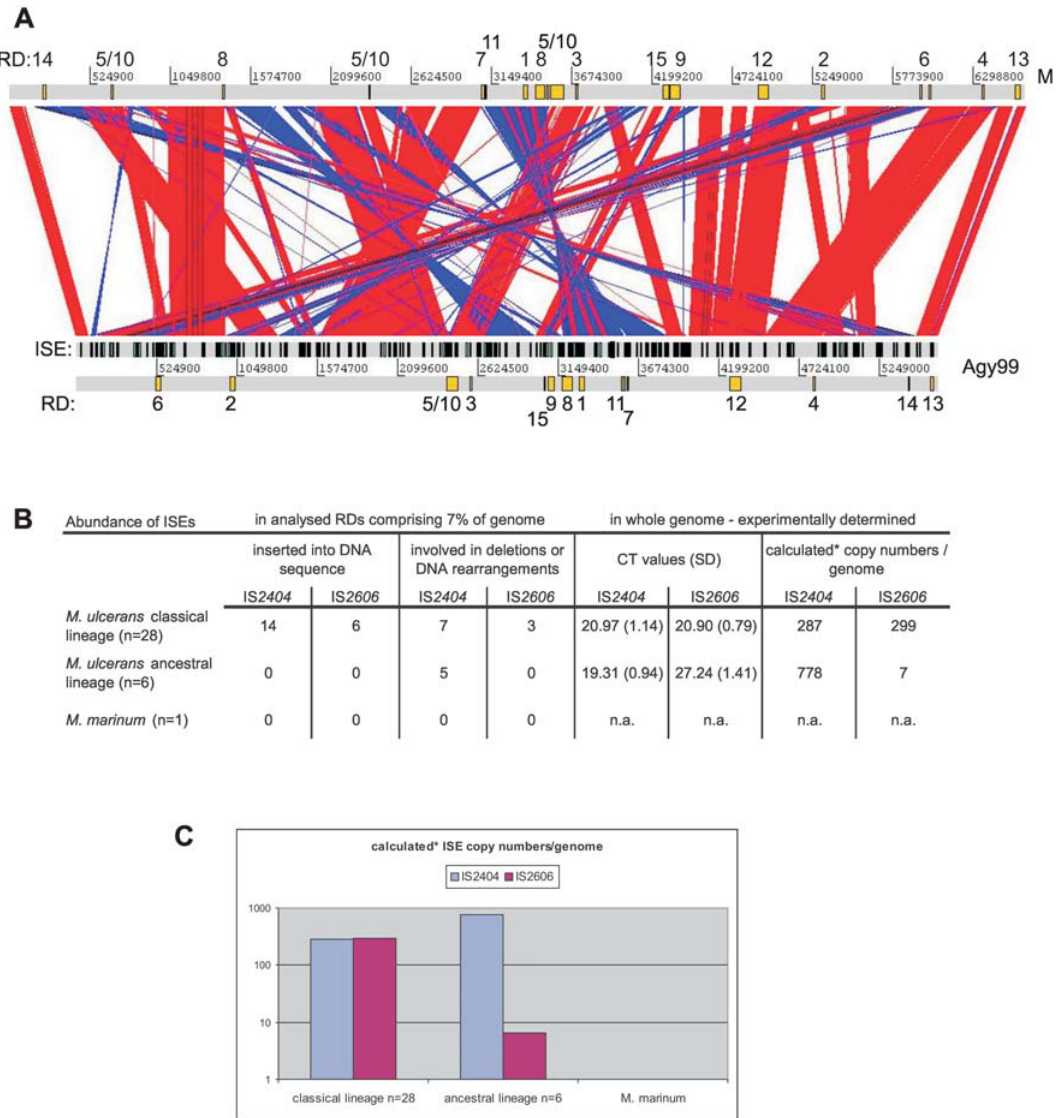
Figure 3. Involvement of ISEs in genomic diversity. A) Positions of the RDs and ISEs on the genomes of M. marinum M (top) and M. ulcerans Agy99 (bottom). RDs1-15 are located at different positions upon alignment of the two genomes, and some RDs occur on several loci on the M. marinum sequence due to genomic rearrangement and dislocations that formed the M. ulcerans Agy99 genome. The ISEs IS 2404 and IS 2606 are indicated as black bars in the marked lane. Sequence comparison was illustrated using the Artemis Comparison Tool software release 5 [31]. B) Test for whole genome abundance of IS 2404 and IS 2606 throughout a world-wide M. ulcerans strain collection (n=34) and M. marinum . Indicated are the numbers of observed ISE involvements in the analysed 7% of the genome and the experimentally determined copy numbers. Whereas M. marinum M and water controls were devoid of ISEs, the abundance of IS 2404 and IS 2606 was measured between the lineages by quantitative real-time PCR. C) CT values were normalized using a unique gene target to account for differences in template input and calculated into copy numbers/genome. *These values reflect approximate numbers calculated from obtained CT values. Note that minor changes in CT value differences result in dramatic changes of determined copy numbers, i.e. the retrieved calculated values for the IS 2606 in the classical lineage, for which a genome information is available, deviate by a factor of three. interact with the environment/host of the bacterial cells (secreted or membrane proteins and PE/PPE proteins). Three of the CDSs are involved in the mycobacterial ESX-1 secretion apparatus, and embR_1 which is involved in cell wall biosynthesis.